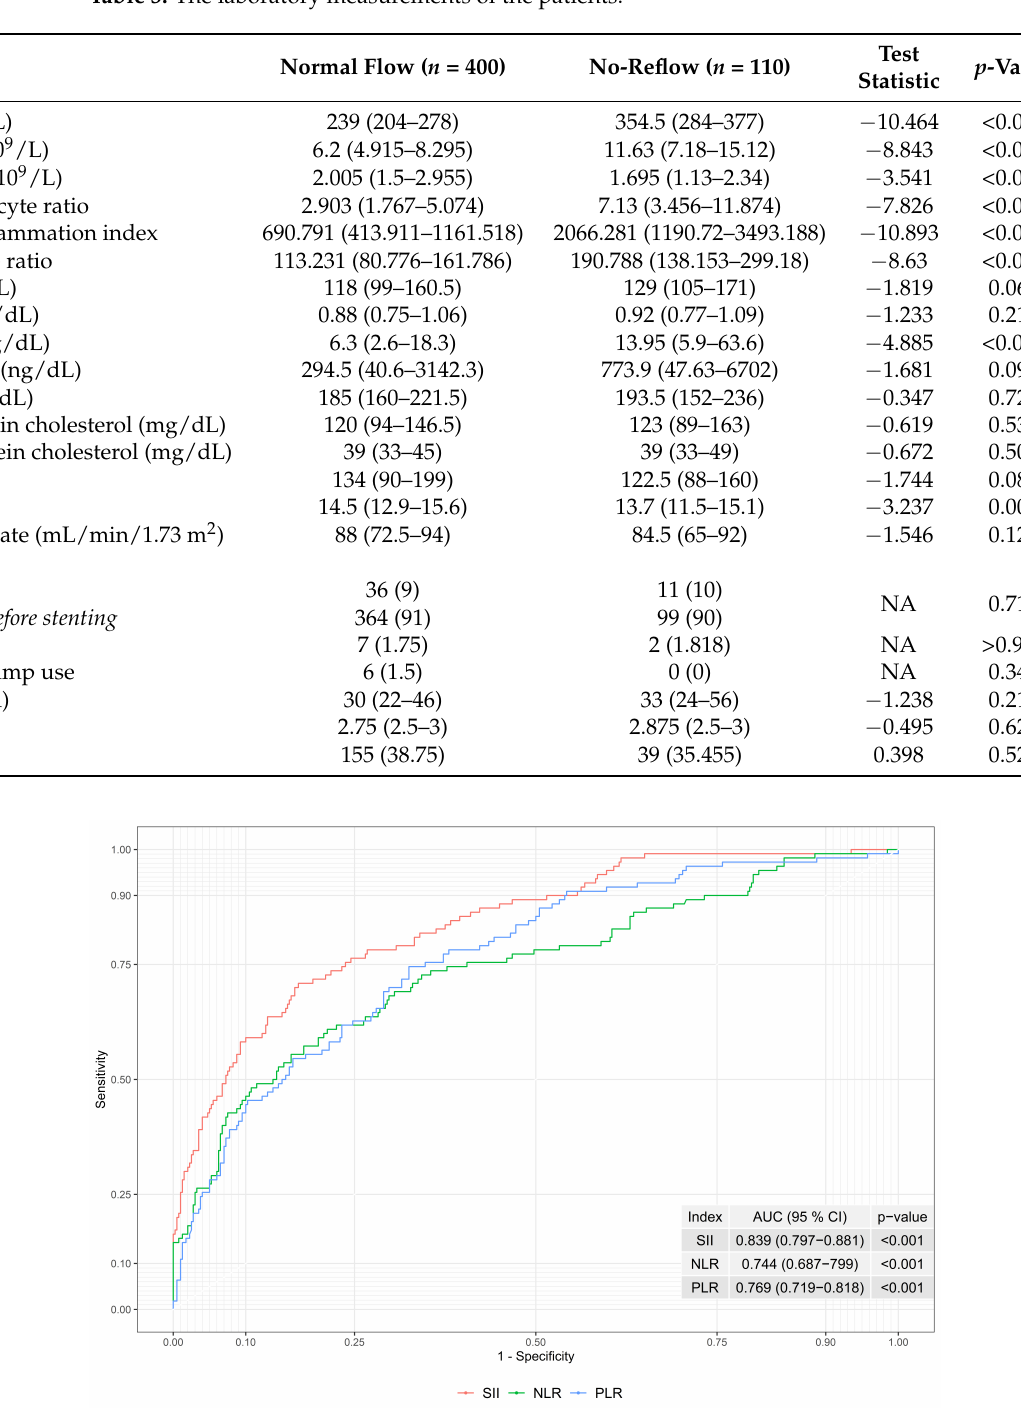
Table 3. The laboratory measurements of the patients.